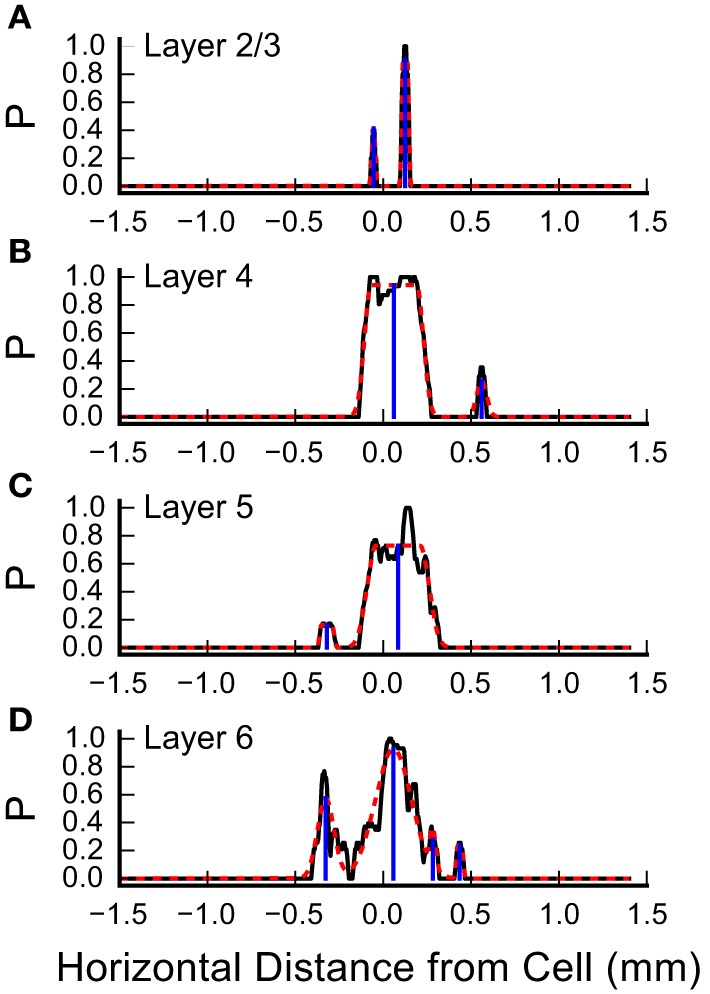
Measurement of the center positions of input sites, by layer. Shown are the summary probabilities of input in each layer for a single cell, as the probability of an identified input site occurring at each horizontal position, collapsed by layer, relative to the cell, plotted with solid black lines. (A) Layer 2/3, (B) Layer 4, (C) Layer 5, and (D) Layer 6. In each plot, the dashed red lines show best fits of flat-topped Gaussians (see Materials and Methods) to the probability profiles. The computed center of mass of the individual Gaussians are shown by the blue drop lines.